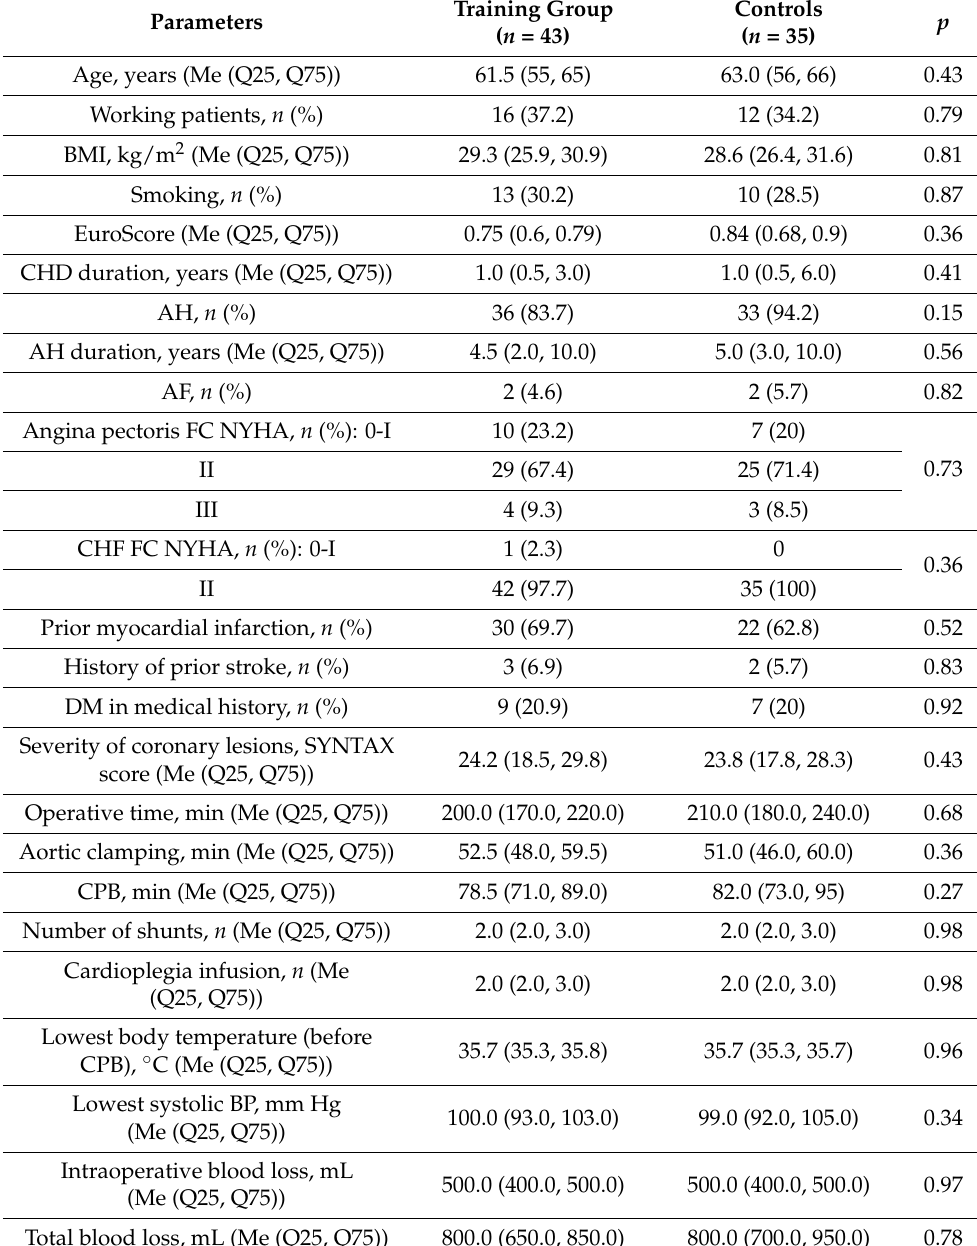
Table 1. Clinical, anamnestic, and intraoperative characteristics of the patients.